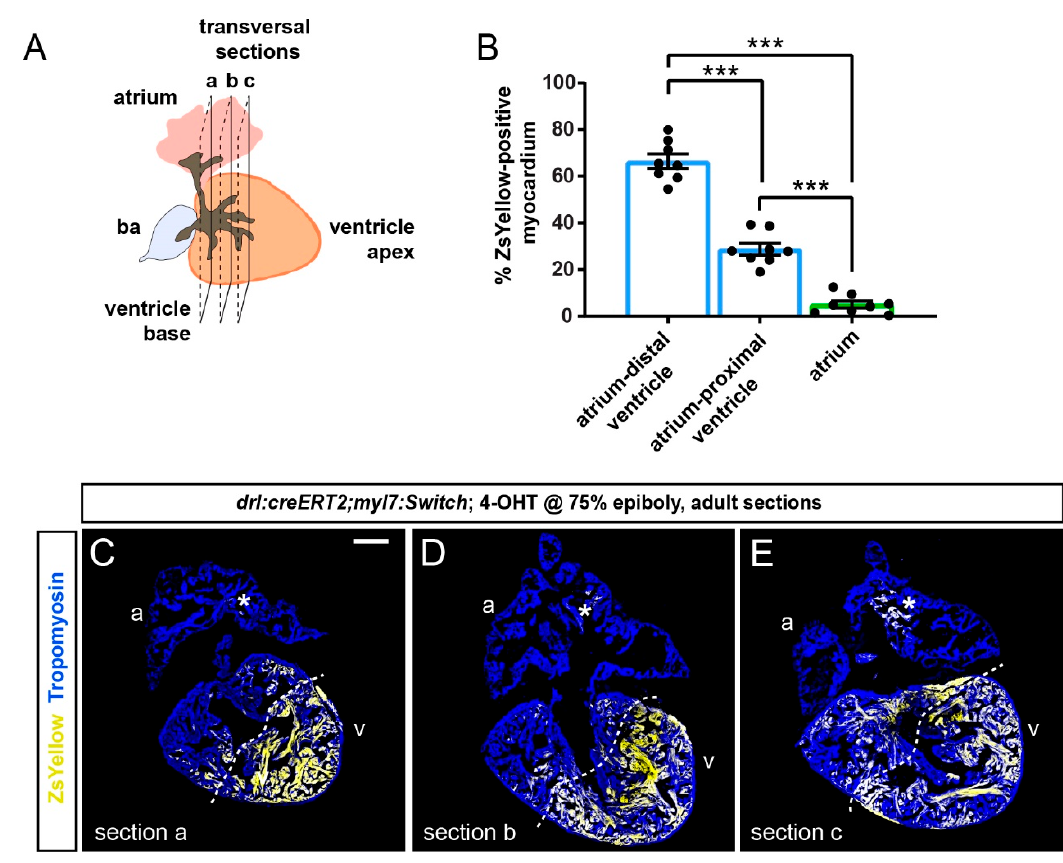
Figure 4. Quantification of localized FHF lineage labeling in the adult zebrafish ventricle. ( A ) Schematic illustration of the adult zebrafish heart with three planes of transversal sections across the region of the ventricle base and the atrium. ( B ) Quantification of ZsYellow-positive cardiomyocyte area in the Tropomyosin-demarcated myocardium indicates predominant labeling in the atrium–distal ventricle, while the atrium–proximal ventricle only retained low numbers of ZsYellow-labeled cells. Note the scarce atrium labeling. One-Way ANOVA test followed by Tukey’s multiple comparison test, *** p < 0.0001 ( n = 8 hearts, 2–3 sections each as per ( A )). ( C – E ) Three sections (a, b, c) of the same heart with the largest tissue area were selected for the quantification of ZsYellow-labeled cardiomyocytes. The dotted line depicts a possible boundary of high- versus low-density ZsYellow labeling. Note that nonetheless, no sharp boundary separates the two areas. Asterisk denotes rare atrial ZsYellow clones throughout sections. Scale bar: 200 µm.